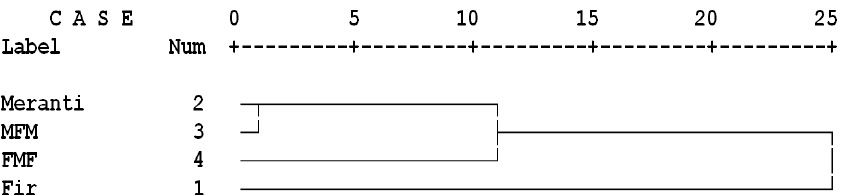
Figure 5. Cluster analysis of the four treatments based on the physical and mechanical properties.